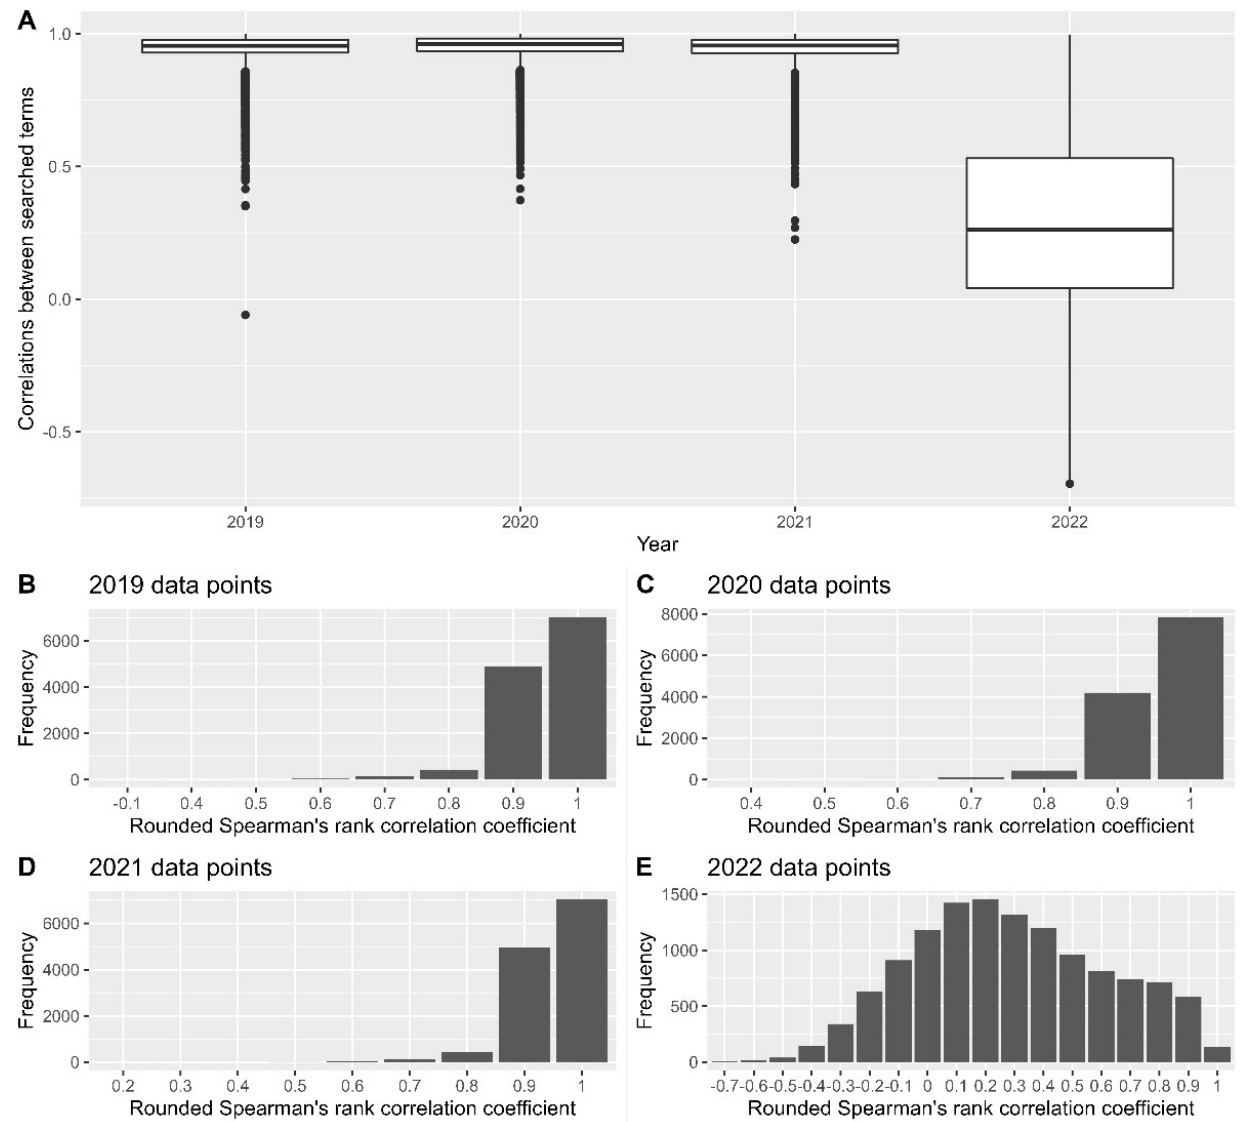
Figure 3. Summary of Spearman’s rank correlation coefficients between 421 terms in 30 countries before and after the implementation of changes to the Google Trends API. ( A – D ) are indicative of highly correlated values for data extracted for 2019–2021, with low levels of correlation in 2022 ( E ).